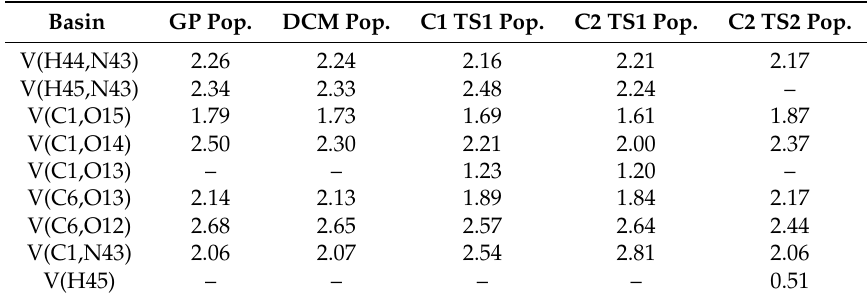
Table 3. ELF population (pop.) analysis for TS structures for the reaction in the GP, DCM, and Configurations C1 and C2 for Scheme